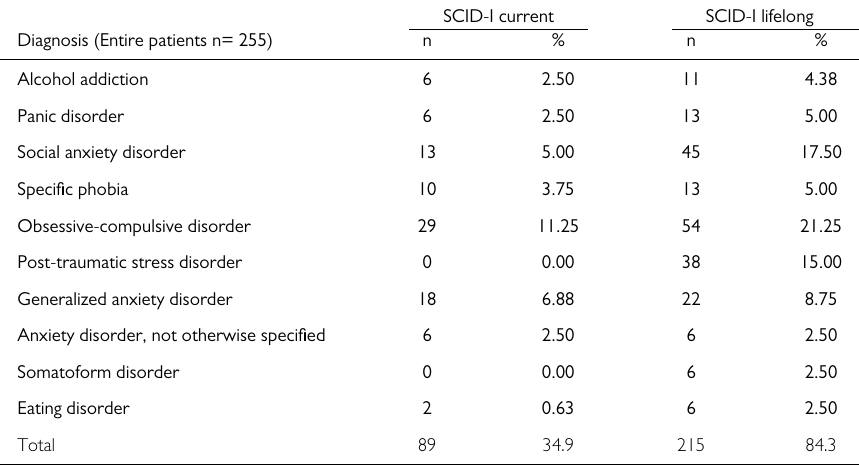
Table 3. Axis-I psychiatric comorbidity rates in bipolar